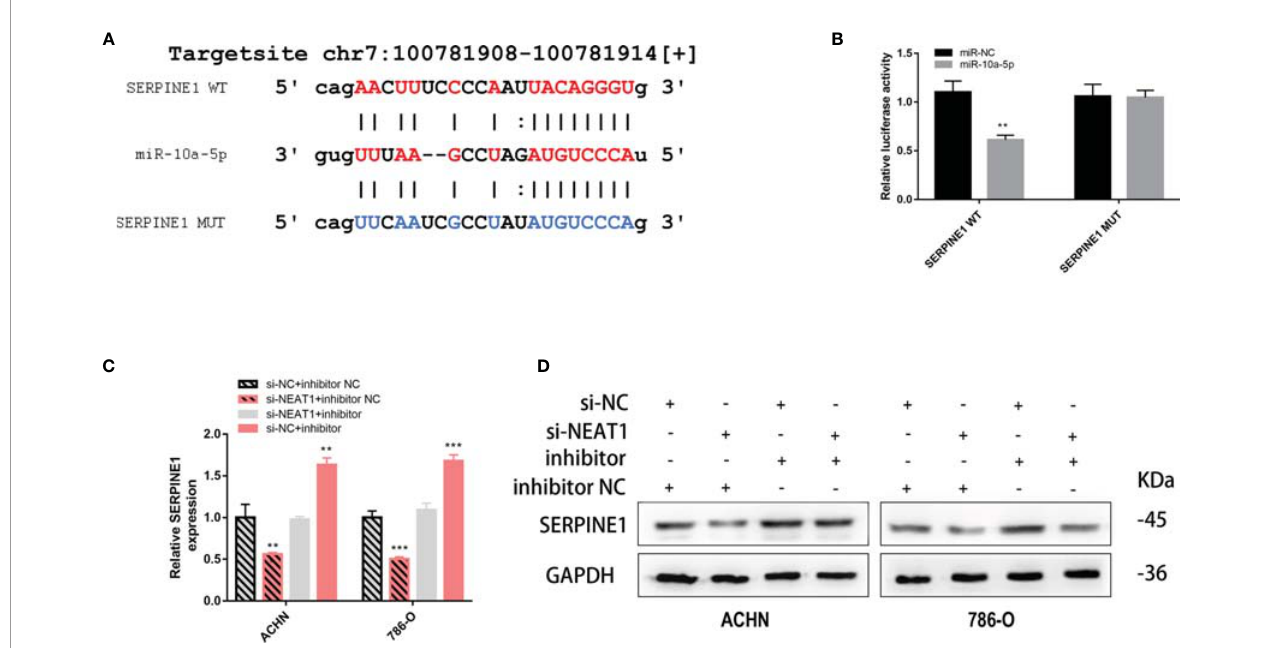
FIGURE 9 | NEAT1 sponging miR-10a-5p to regulate SERPINE1. (A) Prediction the target sequence of SERPINE1 bonding to miR-10a-5p by starBase; (B) Dual luciferase reporter gene assays verify the direct binding of miR-10a-5p to SERPINE1 target sequence; (C, D) Knockdown of NEAT1 can downregulate the expression of SERPINE1 but can be reversed by miR-10a-5p inhibitor. **p < 0.01; ***p <